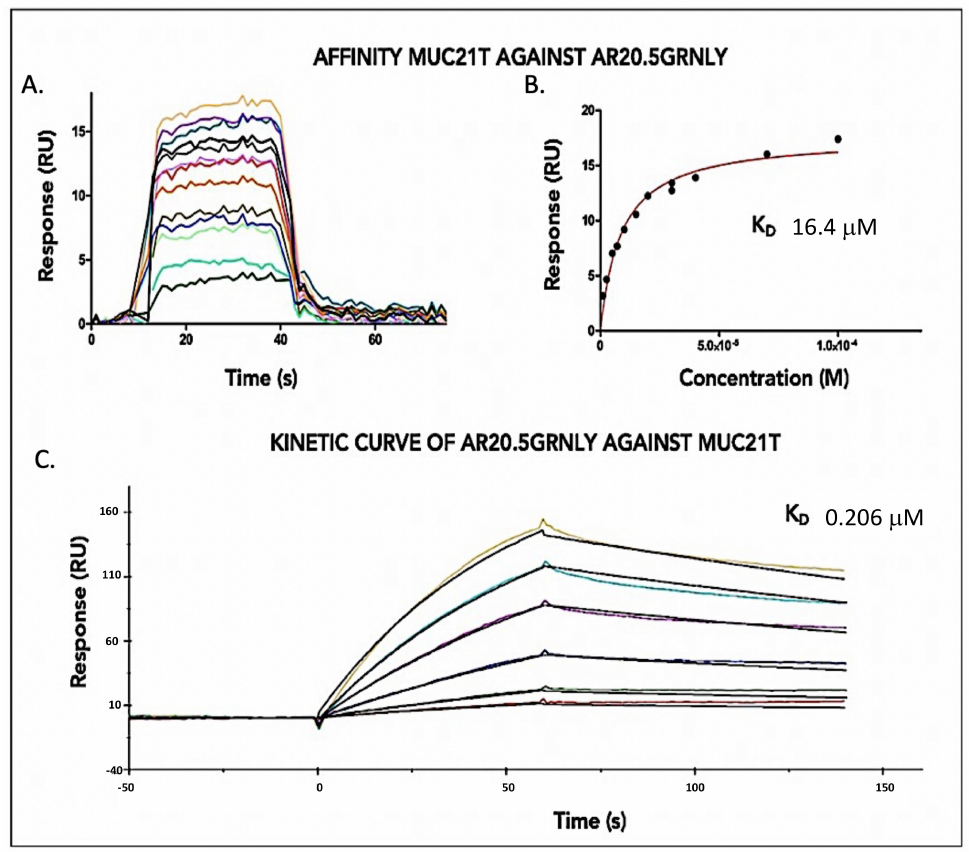
Figure 3. AR20.5GR-MUC1-Tn SPR Affinity Assays. ( A , B ) 6800 RUs of AR20.5GRNLY were immo- bilized on the biosensor, the response was measured with different concentrations of the antigen, varying from 0.07 µ M to 1 µ M. ( C ) Kinetic curve of AR20.5GRNLY when the target was immobilized. Colored lines correspond to the determinations with the different concentrations used in the